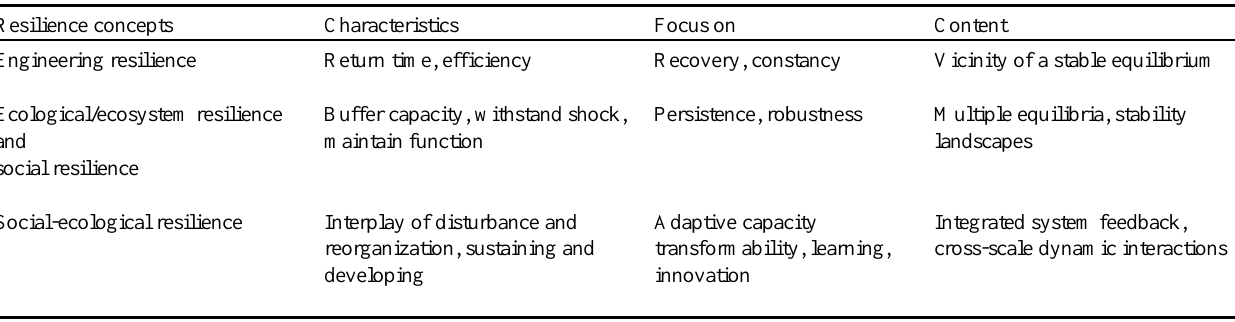
Table 1 . Resilience concepts from the more narrow interpretation to the broader social–ecological